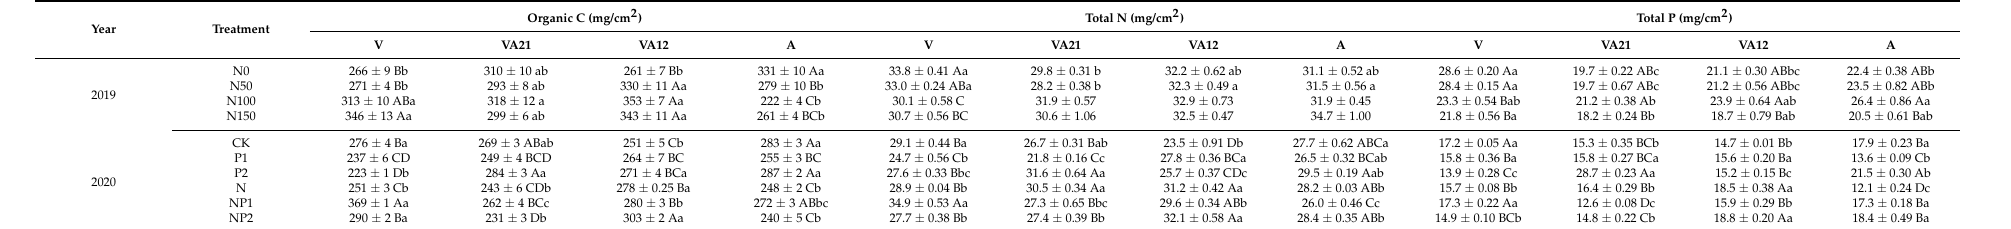
Values are presented as mean ± S.E. ( n = 3). Different capital letters show significant difference among fertilization rates under the same mixing ratio ( p < 0.05). Different lowercase letters show significant difference among mixing ratios under the same fertilization rate ( p <